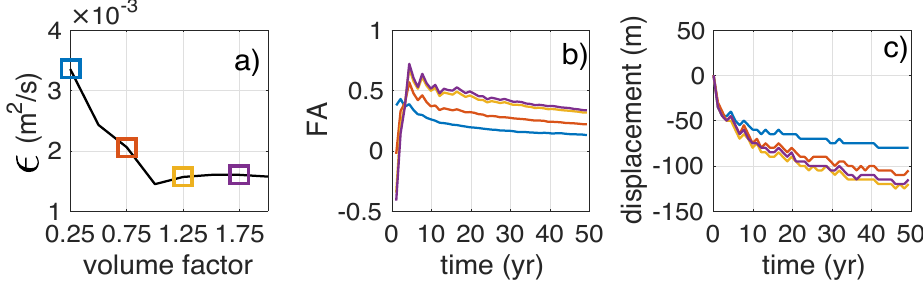
Figure 10. Effect of the initial mega-nourishment volume ratio on: ( a ) the final five-year diffusivity, as well as on the 50-year evolution of ( b ) the FA and ( c ) the